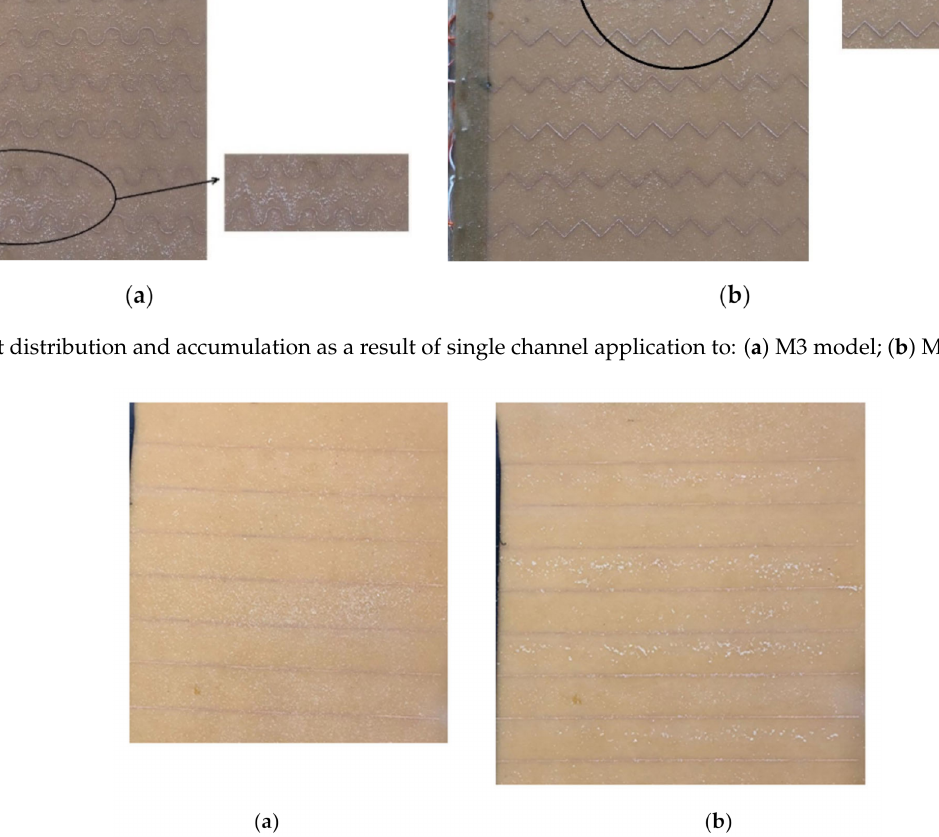
Figure 12. M1 model: ( a ) Before cleaning; ( b ) After